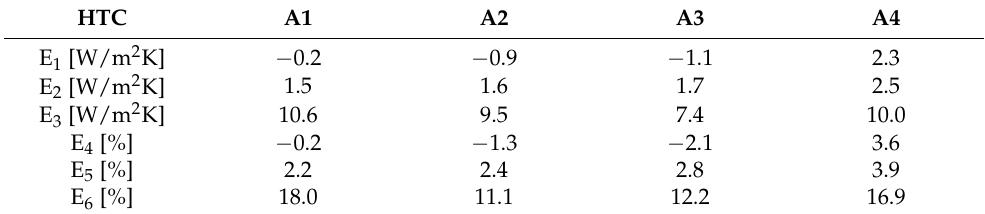
Table 13. Values of estimates E 1 –E 6 for HTC (20)–(25) with heating process p5 in planes A1–A4.